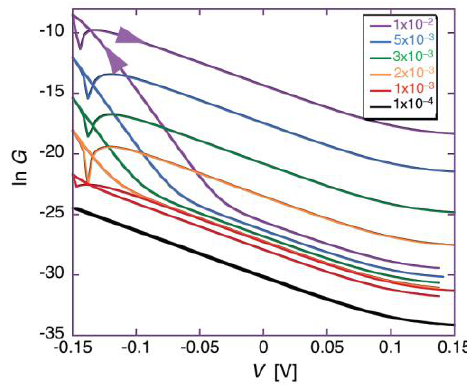
Figure 3. Plots of ln G vs. V for different values of a and for ∆ m = 70 D, θ 0 = 0.1, k N k R 2 = 1 × 10 6 s −3 and n = 1. The curves shift toward progressively lower ln G values with decreasing a . (Reprinted with permission from [38]. Copyright 2015, Elsevier).